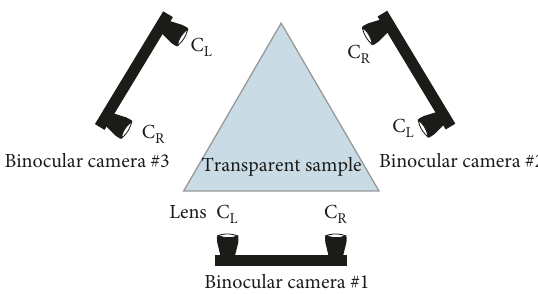
Figure 6: The placement of the binocular cameras.